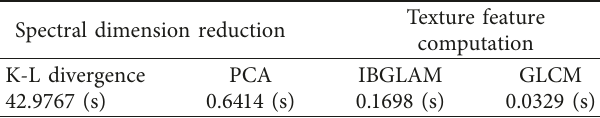
Figure 19: Result of compression of pixel values ((a) original 8-bit image; (b) compressed 4-bit image). Table 6: Processing time when applying the methods described in references [15,